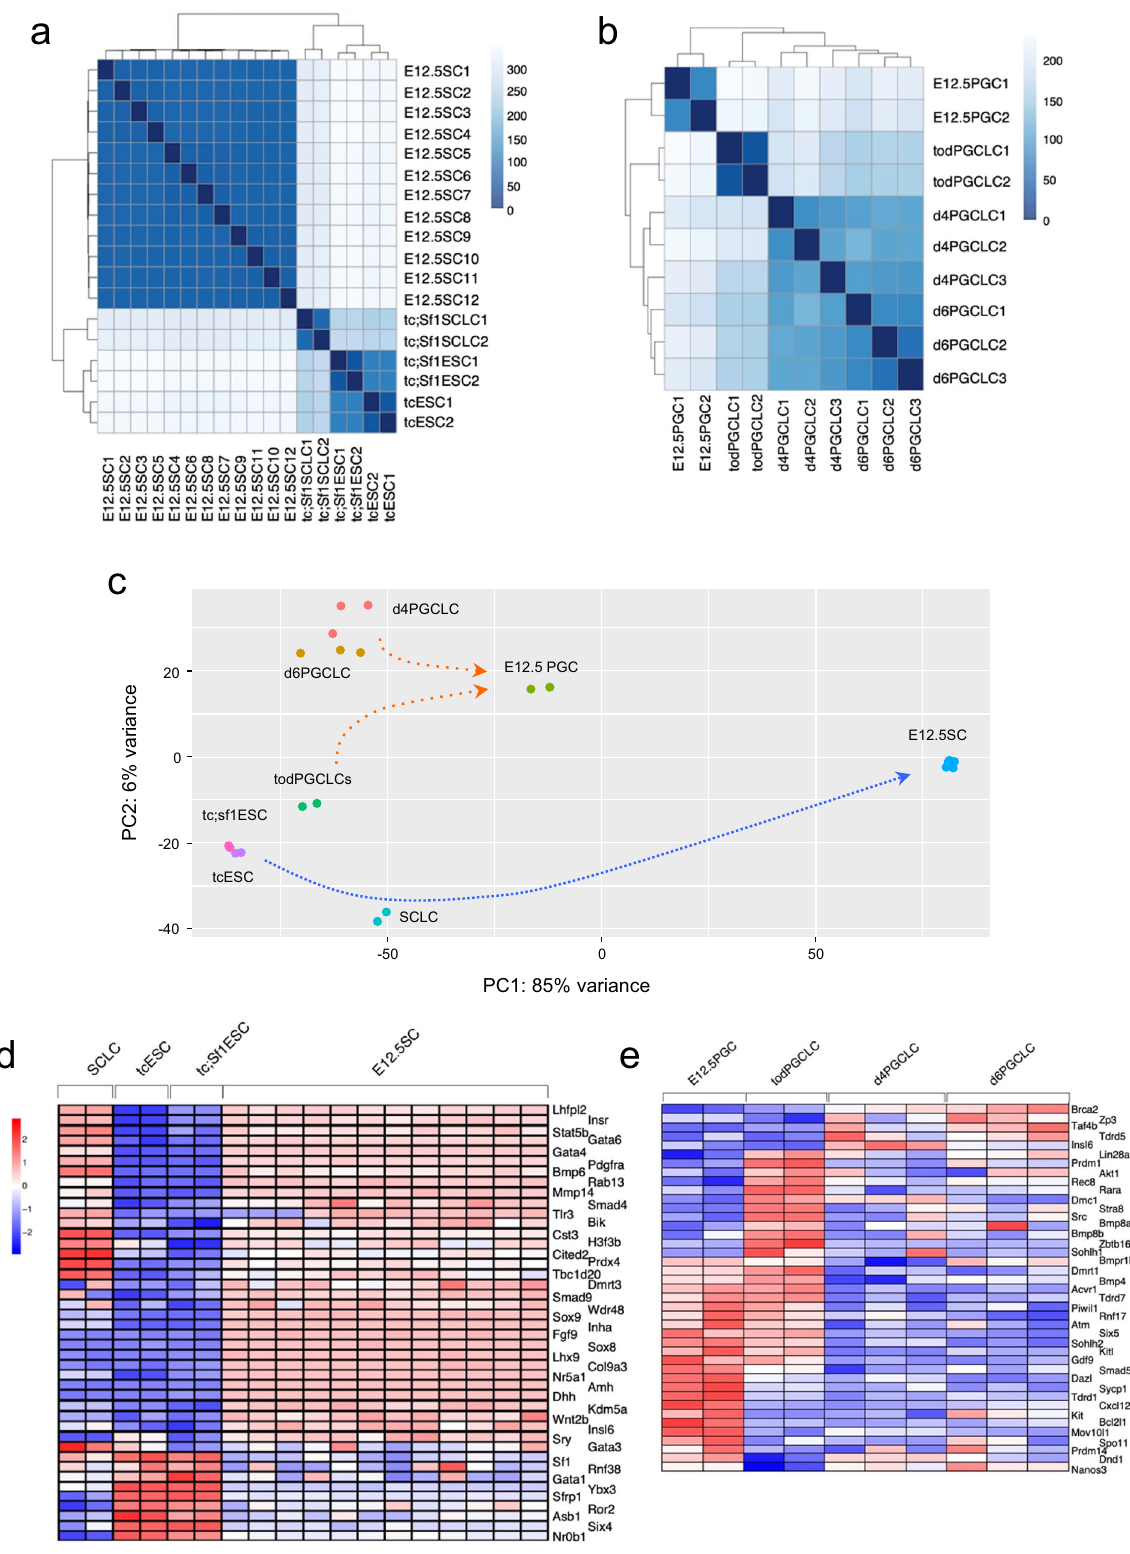
Fig. 5 Global expression pro fi ling during differentiation of ESCs into SCLCs and tod-PGCLCs. a , b Sample distances among tc ESCs, tc;Sf1 ESCs, tc; Sf1 SCLCs and E12.5 Setroli cells (E12.5SC) ( a ), and among tod-PGCLCs, d4PGCLCs, d6PGCLCs and E12.5 PGCs ( b ). c PCA demonstrating changes in global gene expression during SCLC differentiation towards E12.5 Sertoli cells (blue dotted line) and the comparison between tod-PGCLCs, d4/d6PGCLCs and E12.5PGCs (green dotted line). d , e Heatmaps showing relative expression levels of a subset of GO-selected genes in SCLC differentiation ( d ) and PGCLC differentiation ( e ). The full sets of GO-selected genes are shown in Supplementary Fig. 6a,